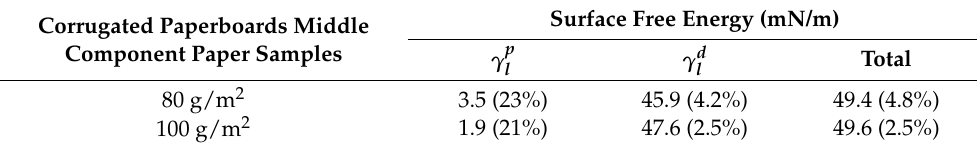
Table 3. Surface free energies of the lignocellulose sheet surfaces. Corrugated Paperboards